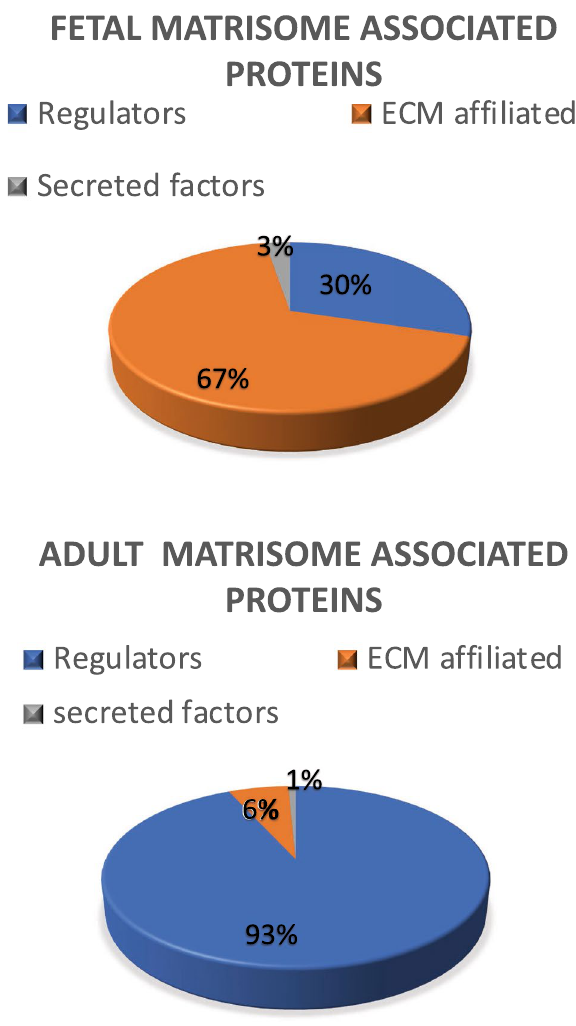
Figure 1. Relative protein distribution. Non-core matrisome composition of fetus and healthy adult NP’s.